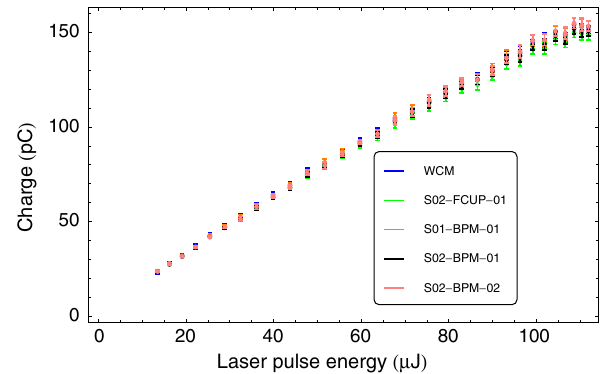
FIG. 28. Charge readings from three CLARA BPMs and two charge diagnostic devices as a function of the PI laser pulse energy. Below a bunch charge of ≈ 25 pC, the BPM readings are no longer